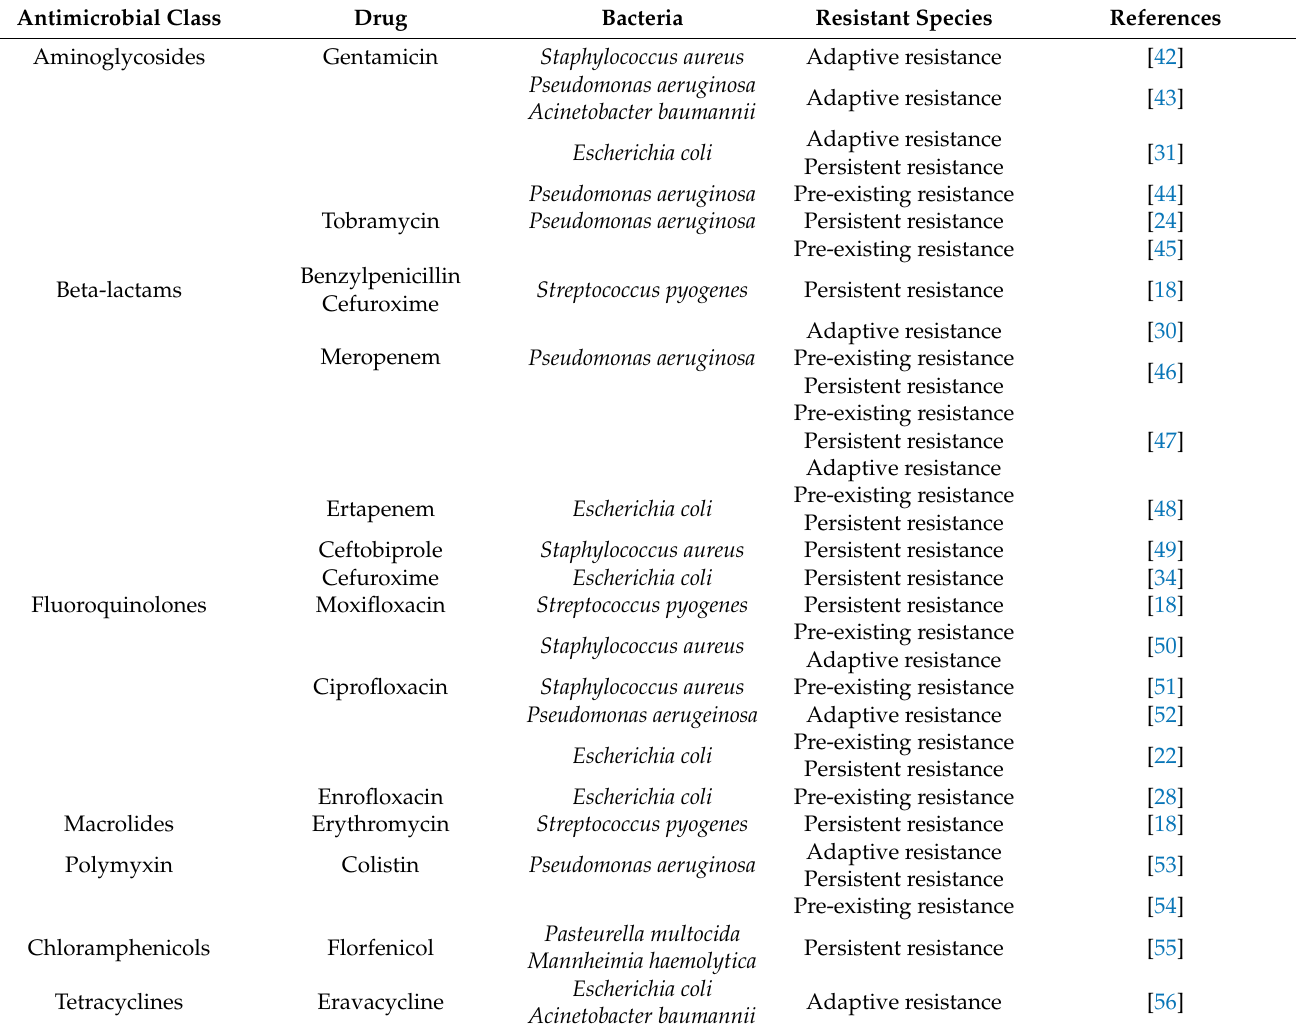
Table 1. The semi-mechanistic PK/PD of antibacterial against different bacterial populations. Antimicrobial Class Drug Bacteria Resistant